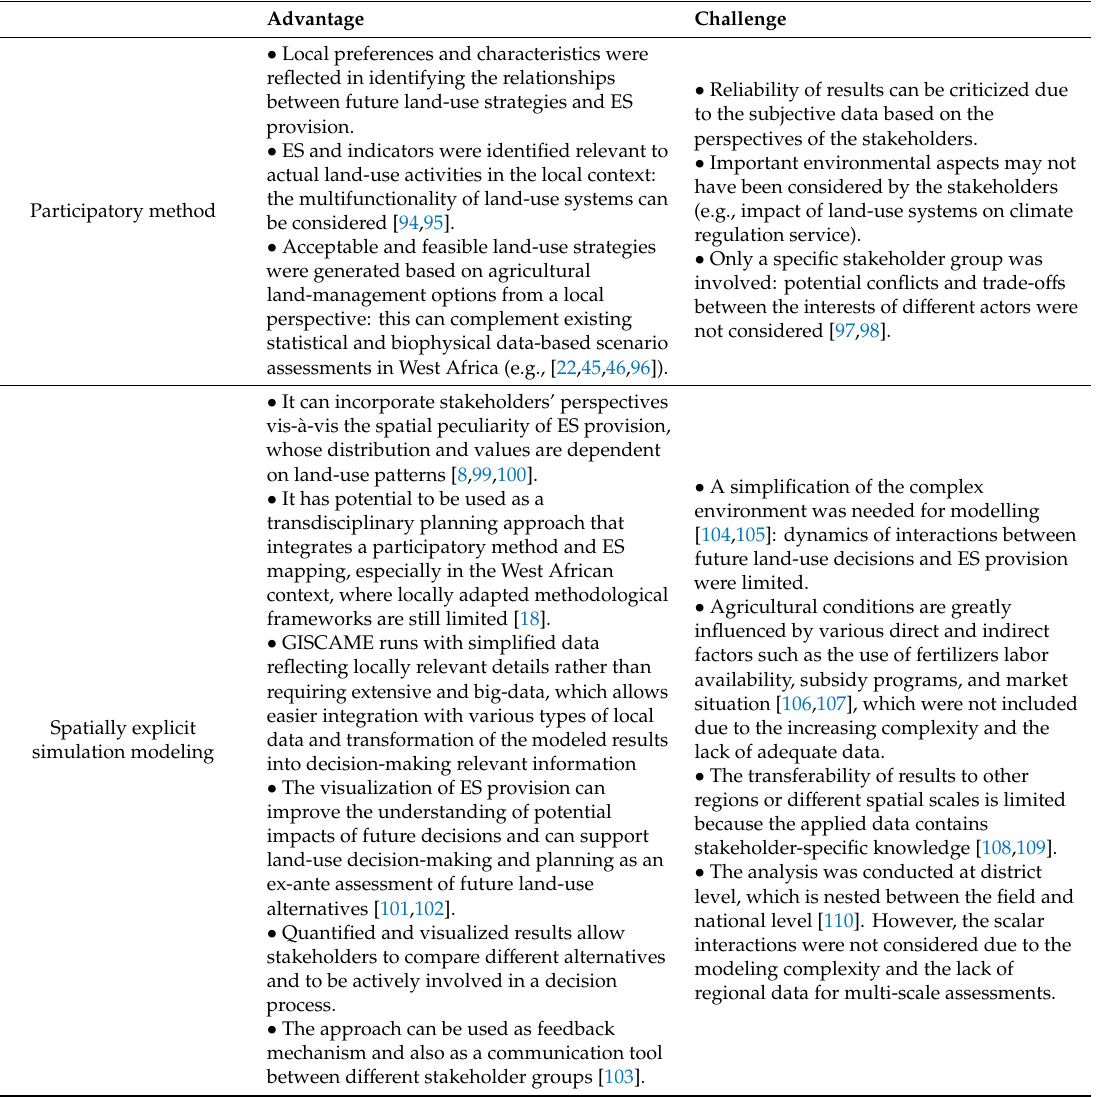
Table 3. Advantages and challenges of applied participatory and simulation modeling